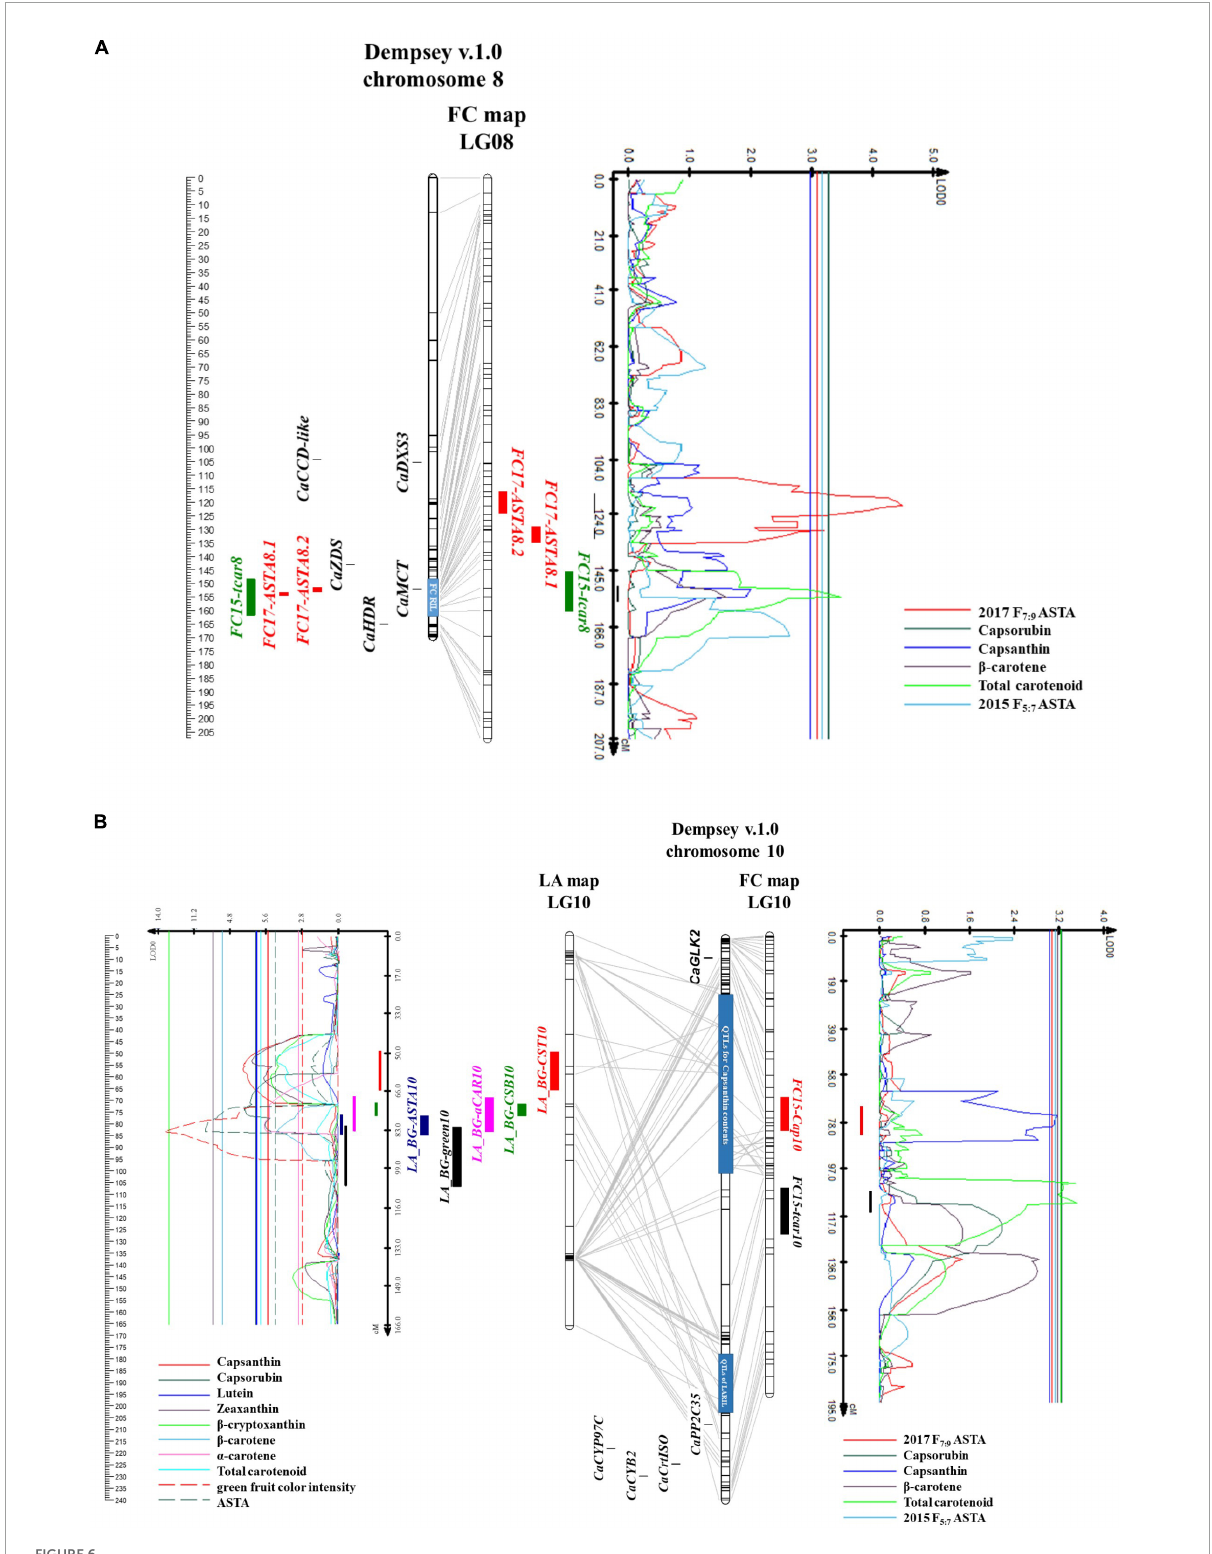
FIGURE6 Physical map based on Dempsey genome, linkage maps of RILs, and QTL likelihood profile containing the QTL positions. (A) Chromosome 8 and linkage group 8 of FC map, (B) chromosome 10 and linkage group 10 of LA and FC map.